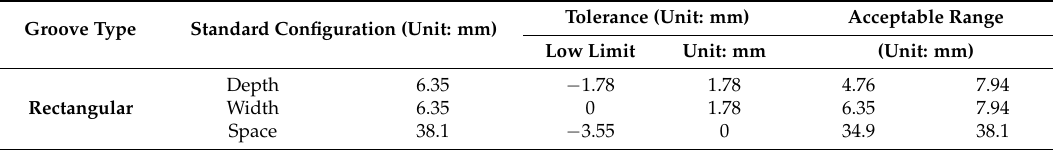
Table 1. Recommended Groove Configuration and the Tolerable Range [2] .